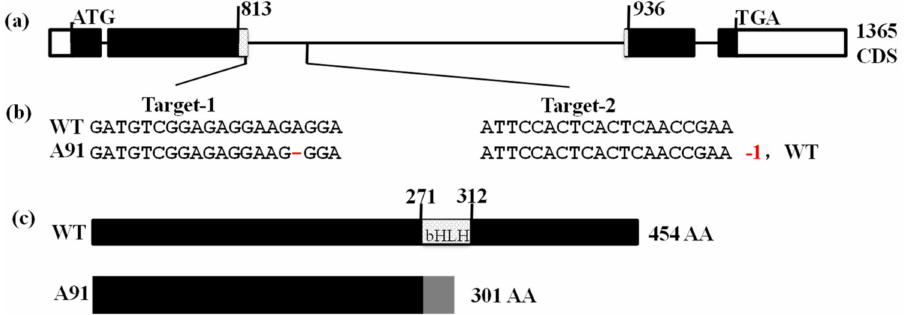
Figure 2. CRISPR/Cas9-induced mutation in the OsbHLH024 ( LOC_Os01g39330 ) gene. ( a ) Schematic diagram of gene structure and two CRISPR/Cas9 target locations, with UTRs, exons, and introns and bHLH domain shown by blank rectangles, black rectangles, black lines, and dotted rectangles, respectively. The 20-nt target sequences are shown at the bottom of the gene structure; ( b ) DNA sequencing and alignments with WT identify the editing genotypes; the deletion is indicated by the red dash; ( c ) the expected protein structure of WT and A91. The dotted and grey showed the bHLH domain in WT and frameshift or premature stop in